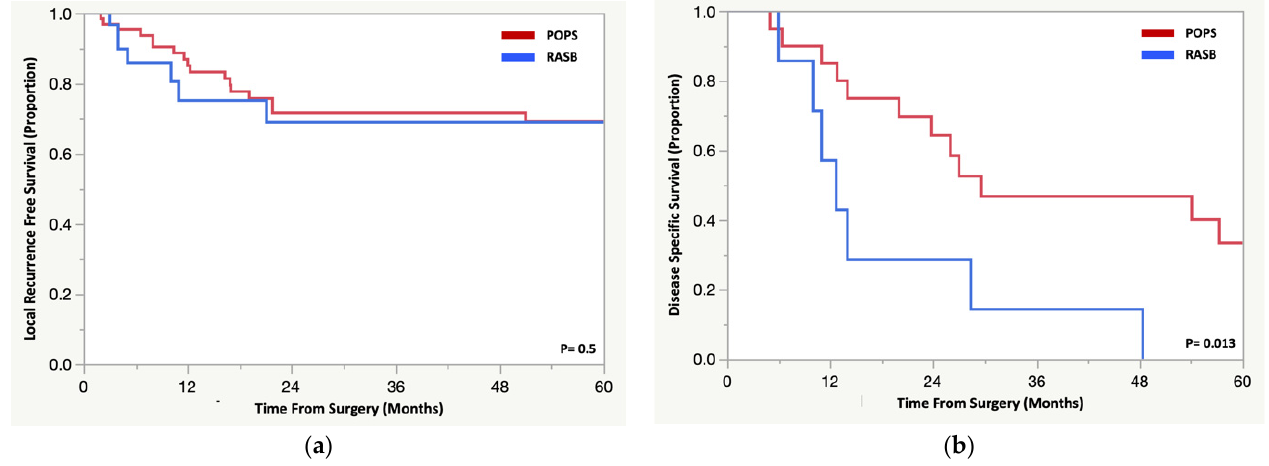
Figure 3. Kaplan Meier analysis comparing patients with a radiation-associated sarcoma of the pelvis/sacrum and a primary osteosarcoma or spindle cell sarcoma for ( a ) local recurrence free survival and ( b ) disease specific survival for patients who developed a local recurrence. There was no difference in 5-year metastasis free survival for patients with RASB vs. POPS (31% vs. 48% p = 0.09) (Figure 4A). Fifteen patients (43%) with RASB developed